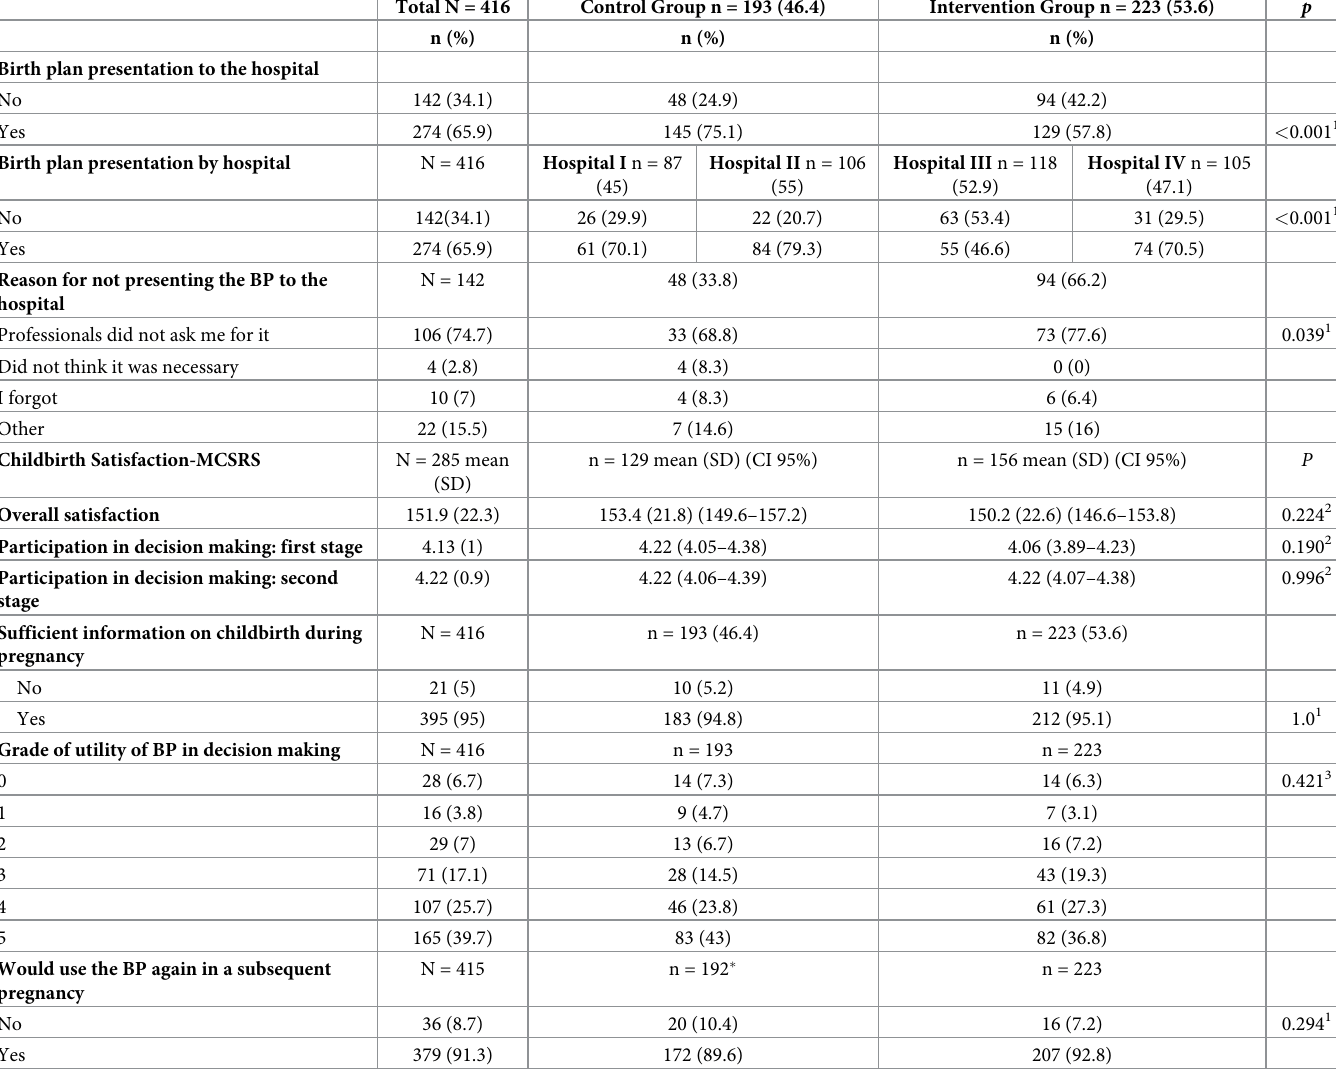
Table 2. Counselling intervention and BP presentation to the hospital, women’s satisfaction with childbirth, experience, information received, and secondary out- comes in both study groups. Total N = 416 Control Group n = 193